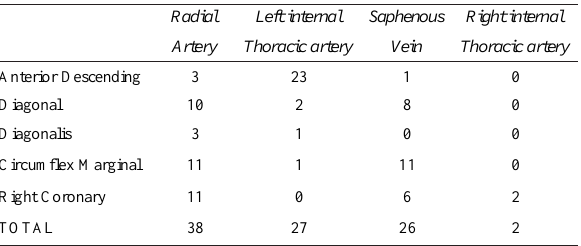
Table 1. Grafted coronary artery and number of grafts used Radial Left internal Saphenous Right